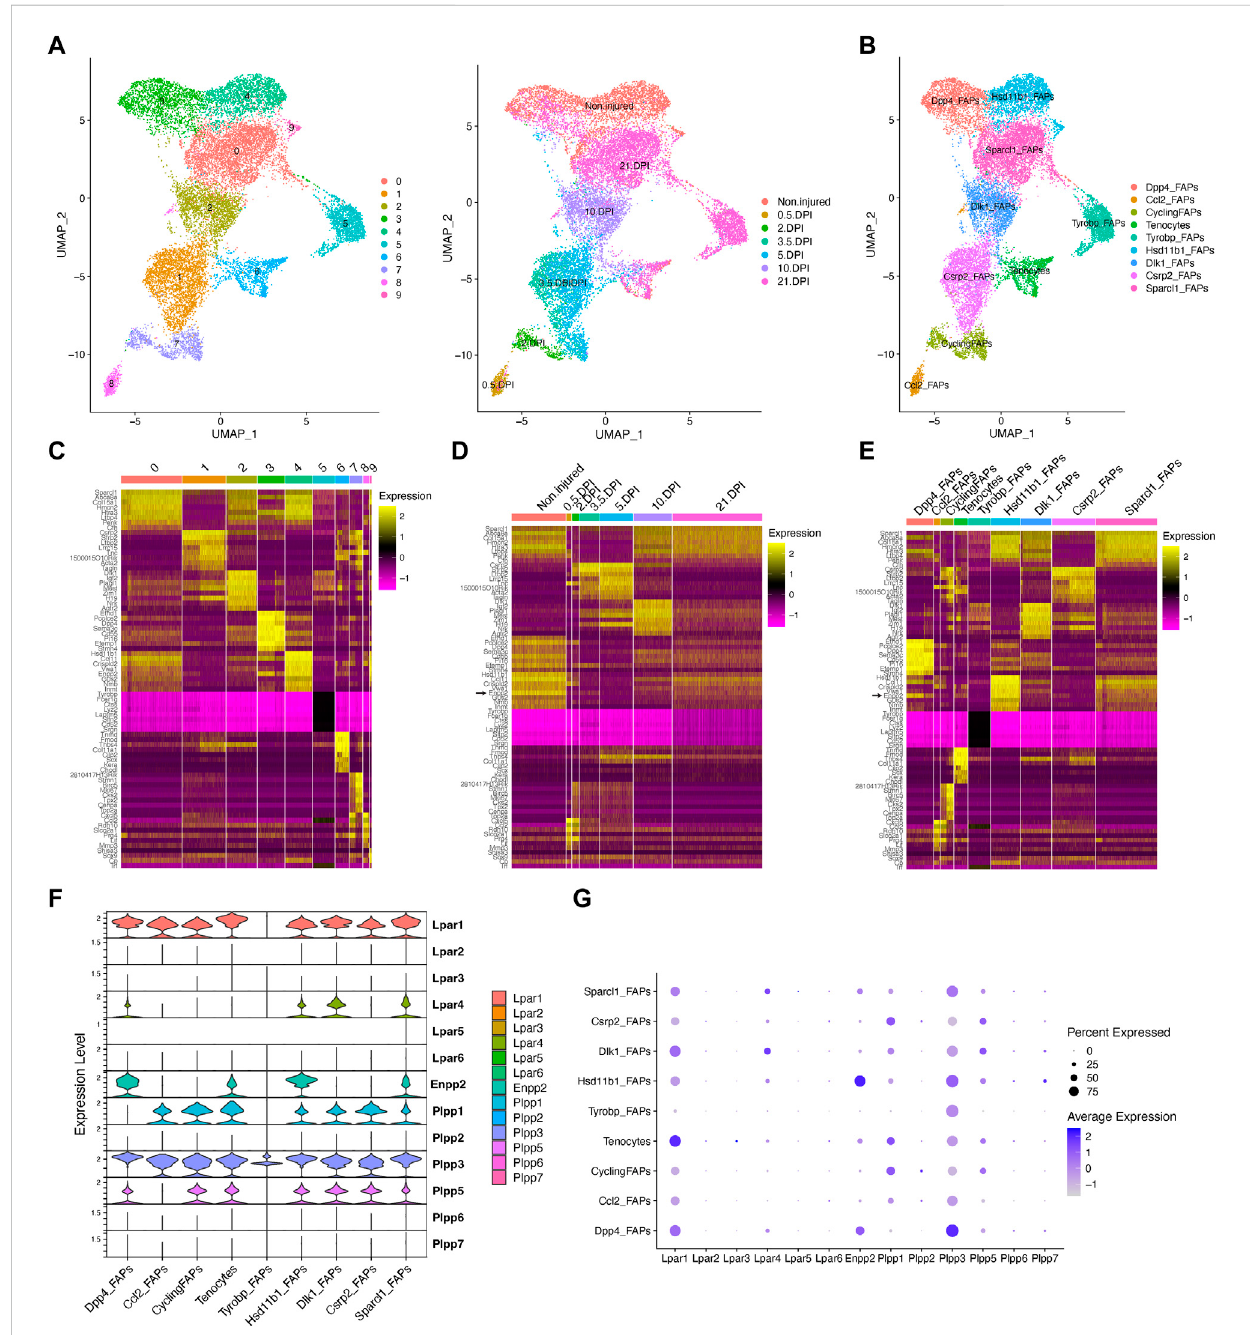
FIGURE 3 Resting fi bro-adipogenic progenitors predominantly express LPA receptors and LPA-producing enzyme ENPP2. (A) UMAP plot showing 10 distinct clusters across skeletal muscle homeostasis and regeneration when subclustering FAPs, DiffFibroblasts, and tenocytes subclusters. Detected major cell lineages and states were colored by the predominant cell type(s) that comprise each cluster (0 – 9). (B) UMAP plot showing nine distinct clusters (eight clustersforFAPlineageandonefortenocytes),whicharenamedbasedonthemosthighly expressed geneintheheatmapsshownbelow (C,E) . (C) Heat map plot showing top eight expressed genes in each individual initial cluster shown in (A) . (D) Heat map plot showing top eight expressed genes in the grouped nine distinct clusters under different conditions [undamaged and days post-injury (DPI)]. (E) Heat map plot showing the named clusters as described in the text, having its name because of one of the top eight expressed genes in each subset. (E) UMAP plot showing individual cells grouped based on the different conditions (uninjured and injured muscle) at different time points. DPI, days post-injury. (F) Violin plots showing the gene expression level of LPAR, Enpp2, and Plpp family members across the different FAPs and tenocytes subclusters. (G) Dot plot showing gene expression levels of Lpar , Enpp2 , and Plpp family members. Note that Dpp4 and Hsd11b1 FAPs highly express Enpp2